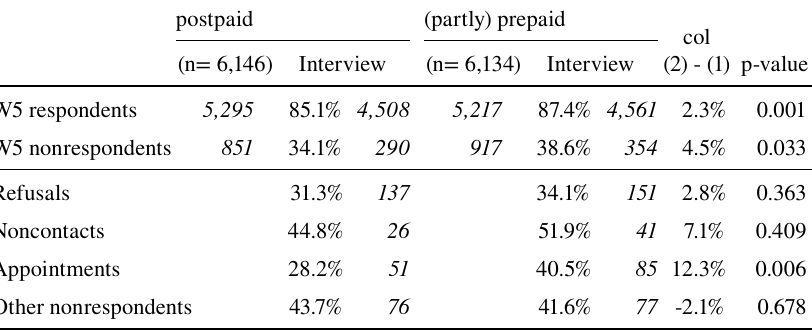
Wave 6 Response Rates by Wave 5 Outcome (N= 12,280)